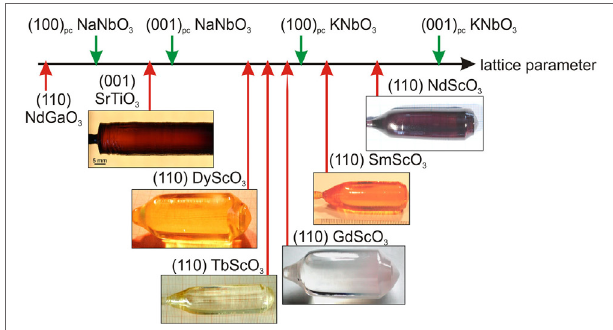
FigUre 1 | Schematic presentation of the pseudocubic (pc) lattice parameters of NaNbO 3 and KNbO 3 (end members of the solid-solution K x Na 1 − x NbO 3 ) as well as the average in-plane lattice parameters of different perovskite-like substrate surfaces. The rare-earth scandates ReScO 3 (Re = Dy, Tb, Gd, Sm, Nd) are all grown at the Leibniz Institute for Crystal Growth (Uecker et al., 2006, 2008, 2013; Coh et al., 2010; Guguschev et al., 2015). A part of the figure is reproduced from Guguschev et al. (2015) with permission from the Royal Society of